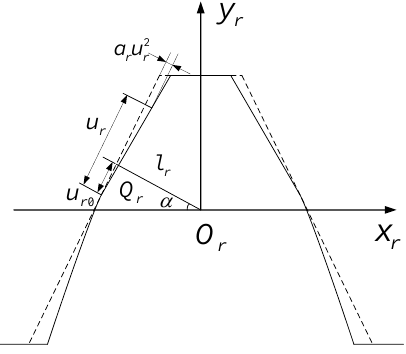
Figure 1. Tooth-profile modification of design of rack cutter. The coordinate system of the honing wheel for the rack cutter is provided in Figure 2. S r ( x r , y r , z r ) is the rack tool’s motion coordinate system, while S h ( x h , y h , z h ) is the honing tool’s motion coordinate system. S h ( x h , y h , z h ) is the coordinate system fixedly connected to the frame. In Figure 2, r ph is the pitch radius of the honing tool, r ph ϕ h is the rack tool’s displacement, and ϕ h is the rotation angle of the honing tool in relation to the rack tool’s movement.